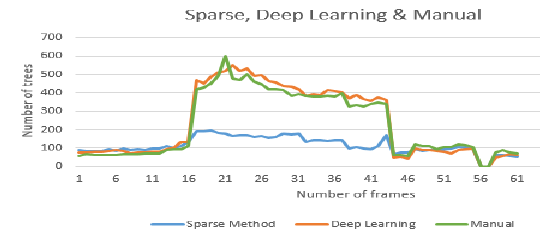
Figure 21 A Comparative Graph Between Sparse Count, Deep Learning Count and Manual Count. Figure 21 shows line graph comparison of deep learning count, sparse count and manual count. From the graph the conclusion can be made that deep learning count is close to sparse count and manual count in the sparse region.